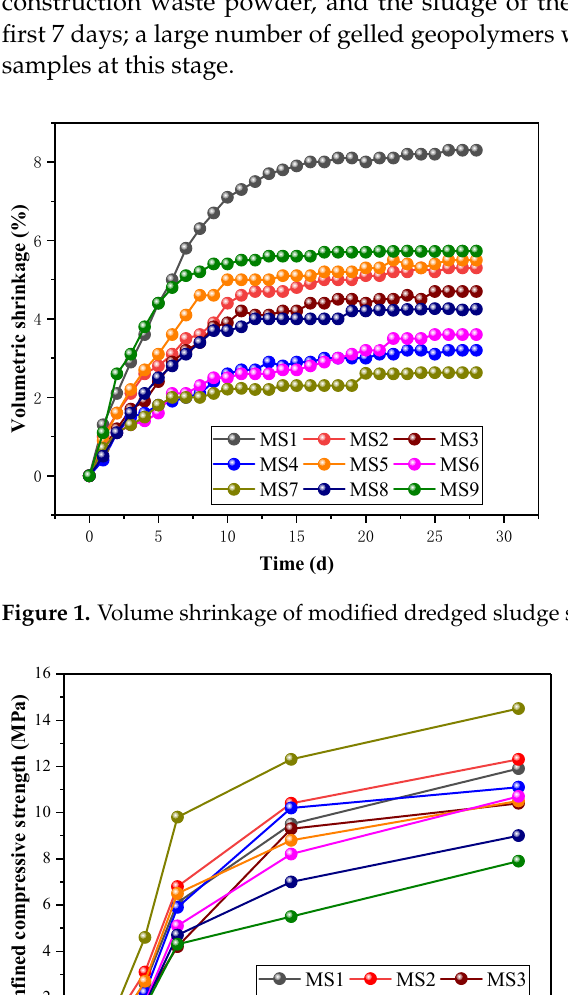
Figure 1. Volume shrinkage of modified dredged sludge samples.